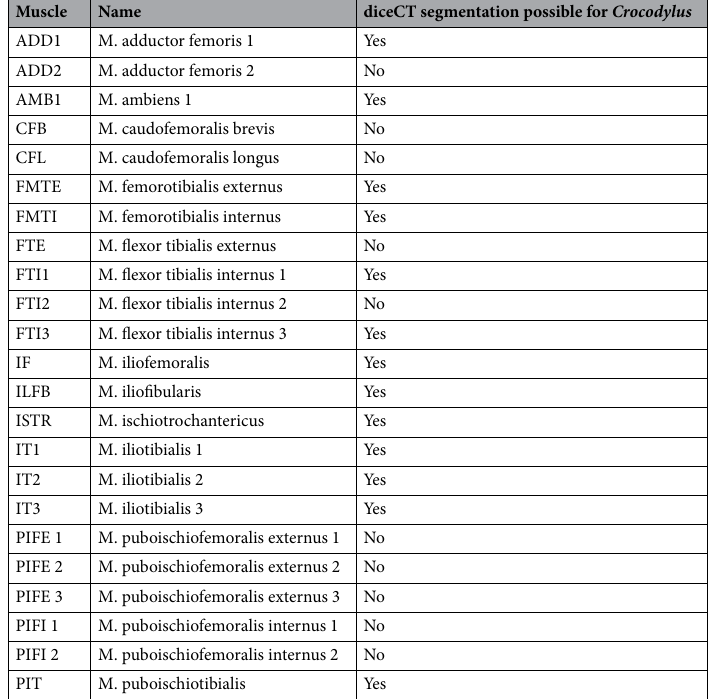
Table 2. Crocodylian thigh muscle abbreviations. Several muscles could not be segmented as the iodine staining was not homogenous and muscle boundaries could not be reliably identified for the whole muscles, thus potentially conflating their volumes with other muscles (e.g. ADD2 and PIFE3 or FTE and FTI2). These muscles were therefore excluded from the dataset. Other muscles were not fully captured in the scan window (e.g. CFB, CFL, PIFE1-3 and PIFI1-2) and could therefore not be fully